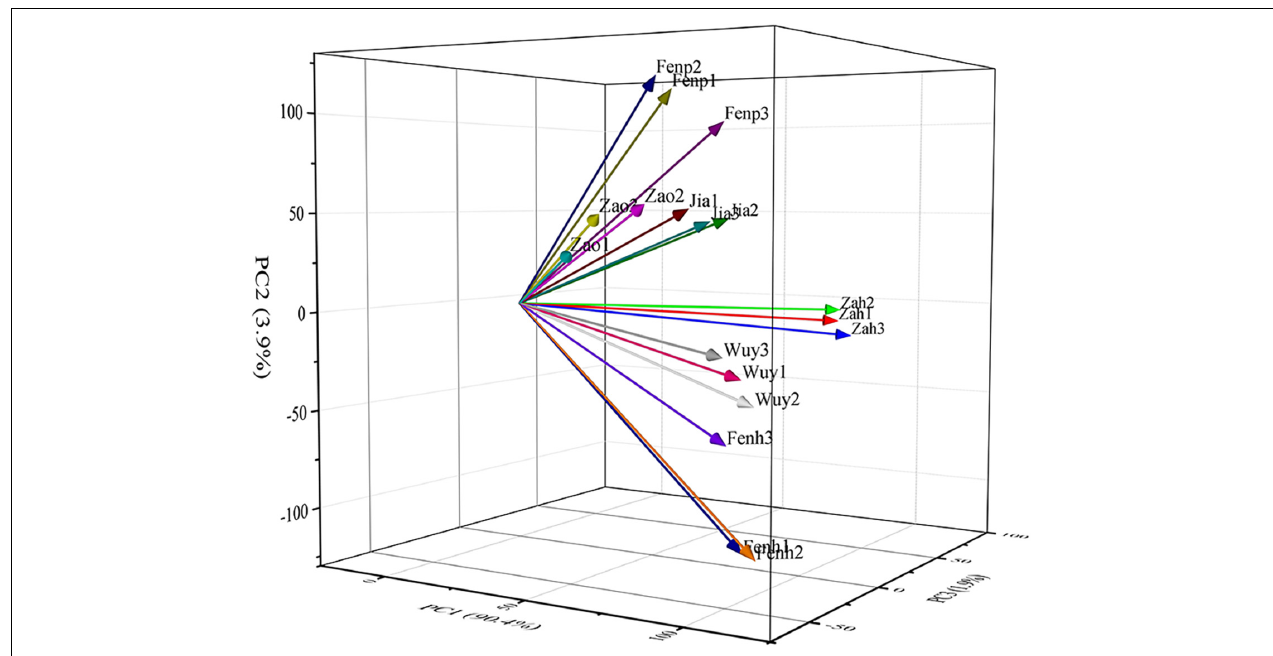
FIGURE 2 | Principal component analysis of the